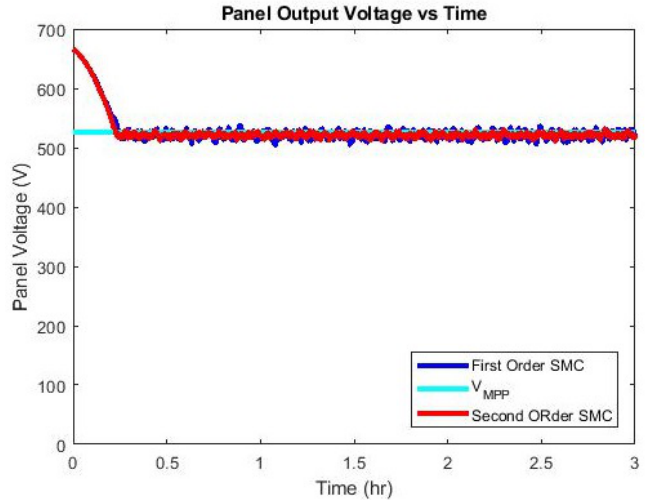
Figure 12. PV array output voltage at 1000 W/m 2